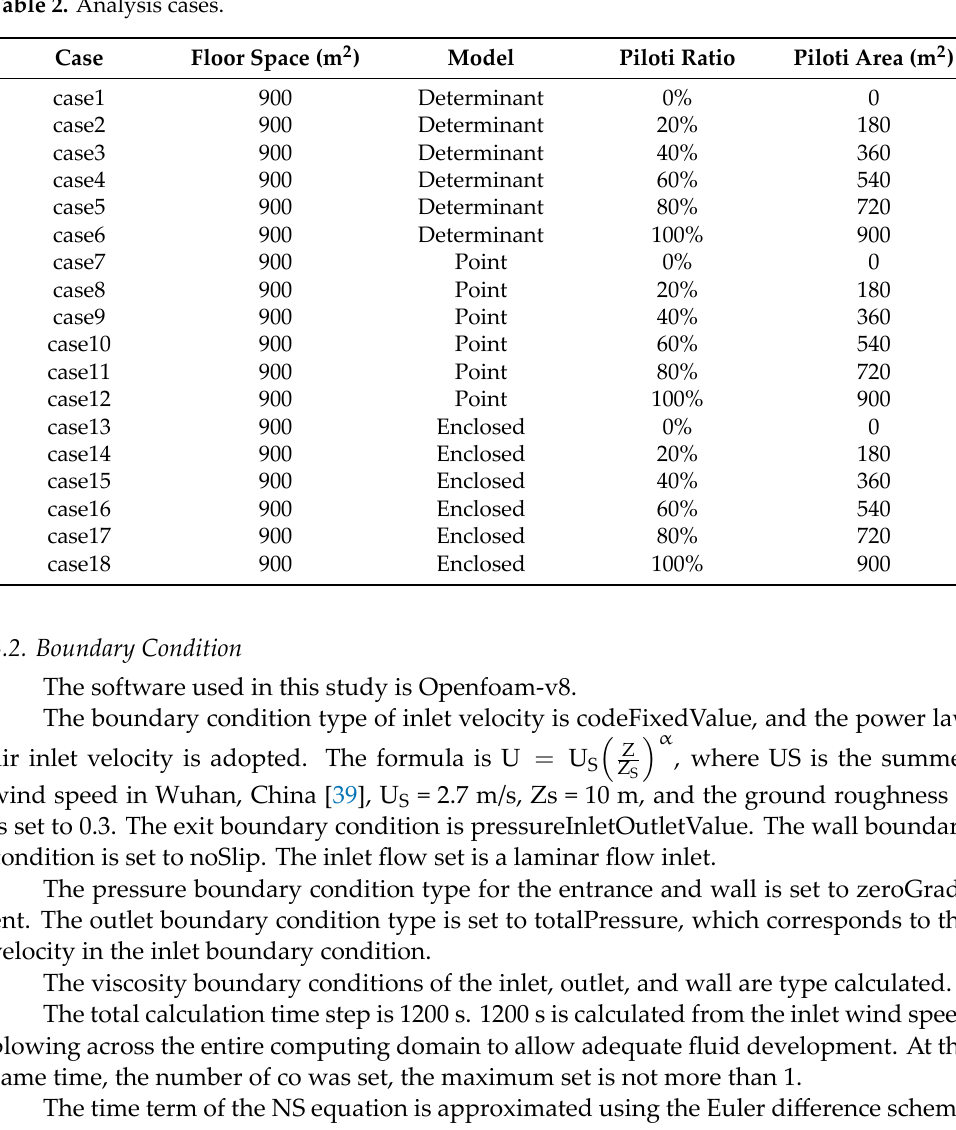
Figure 4. Building model piloti diagram. Table 2. Analysis cases.